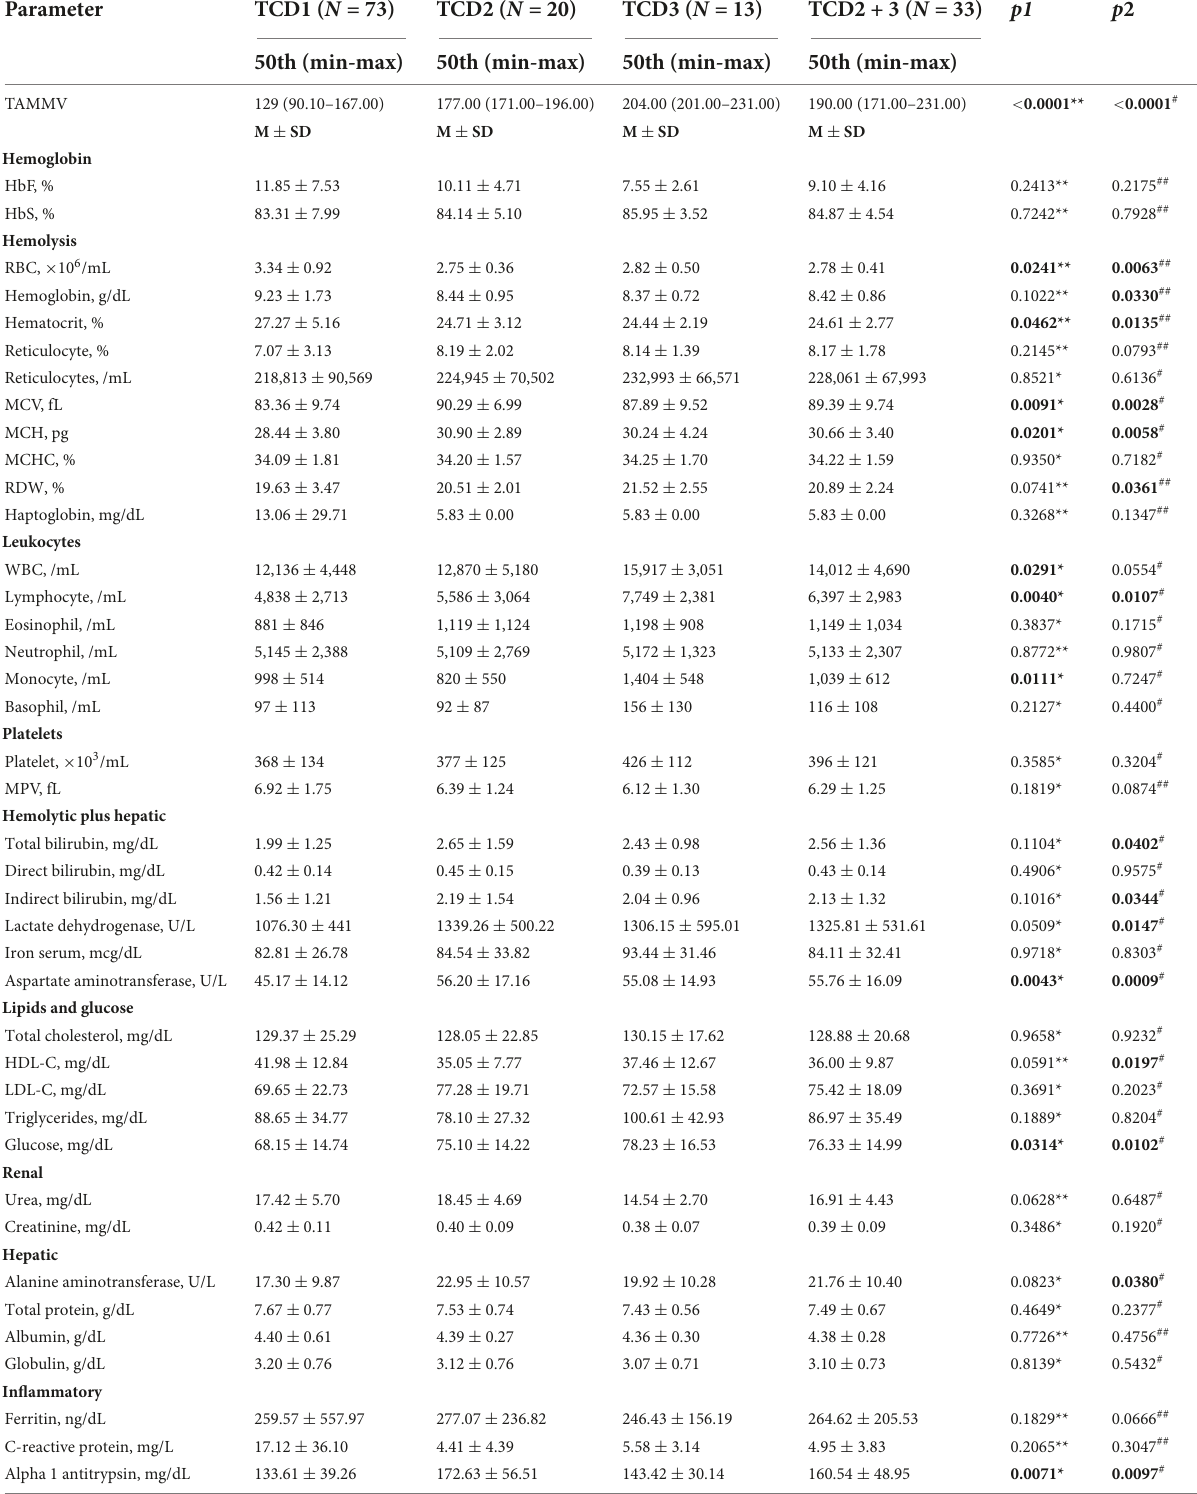
TABLE 1 Laboratory parameters of children with sickle-cell anemia (SCA) without stroke and HU treatment according to Transcranial Doppler (TCD).